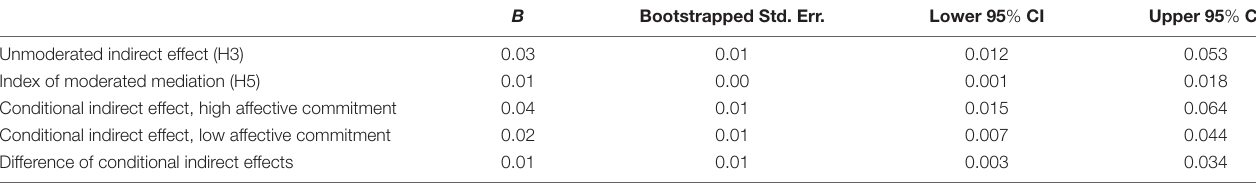
TABLE 3 | Indirect effects of flexibility on performance.